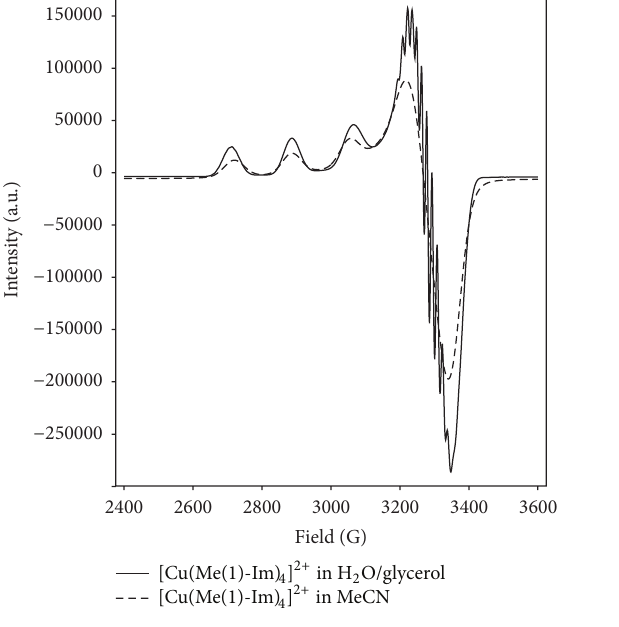
Figure 10: EPR spectra of a tetragonal Cu(II) complex with 1- methylated imidazole in a mixture of water and glycerol (—) and acetonitrile (- -